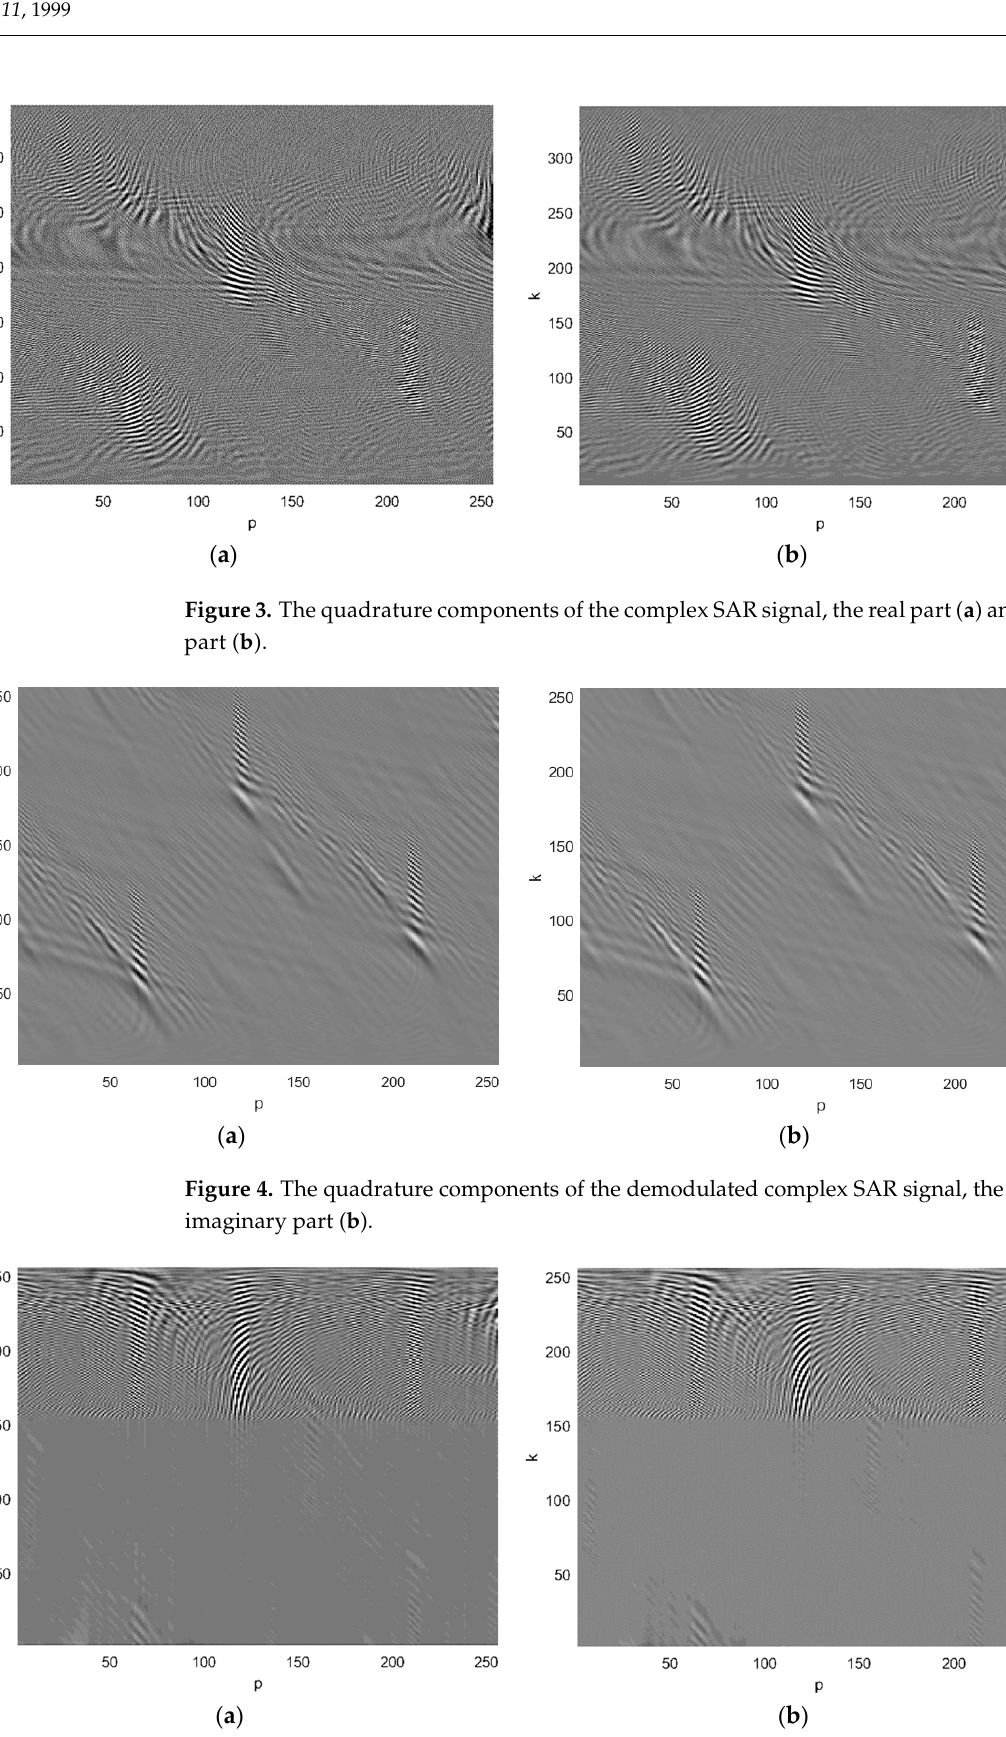
Figure 5. The quadrature components of the range-compressed complex SAR signal, the real part ( a ) and the imaginary part ( b ).